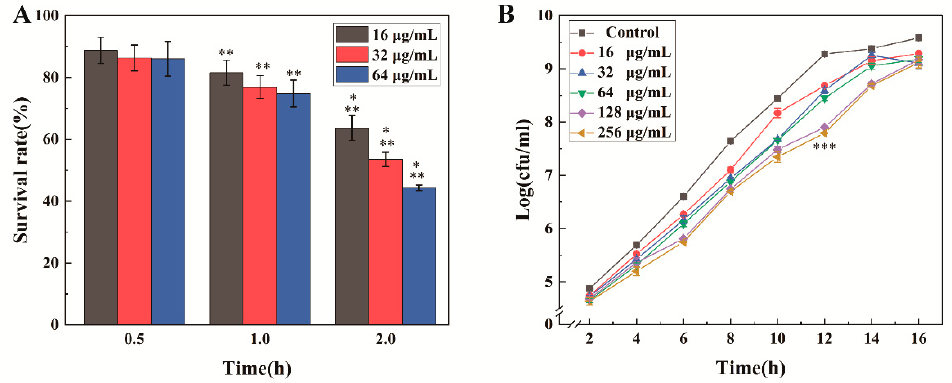
Figure 1. The effect of mannosylerythritol lipids-A (MEL-A) on bacterial growth. ( A ): survival rate of L. monocytogenes treated with MEL-A; ( B ): the effect of MEL-A on the L. monocytogenes growth curve. * (one asterisk) indicates a significant difference in the comparison between different